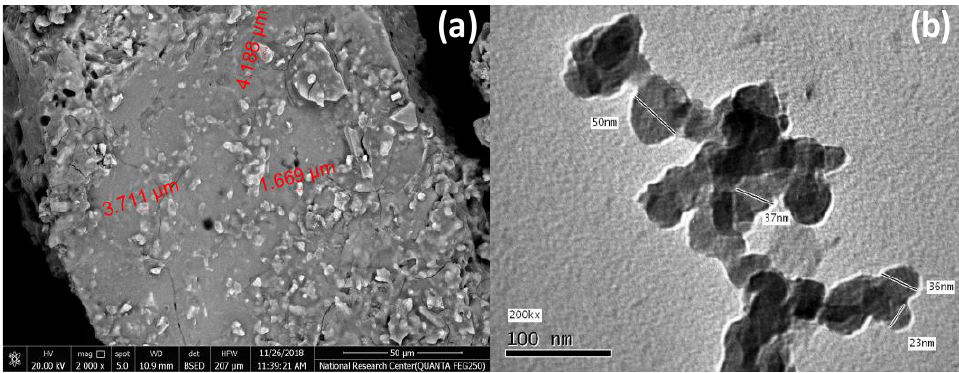
Figure 4. ( a ) SEM image of palm tree fiber carbonized at 400 °C and ( b ) TEM image of PTFAC.